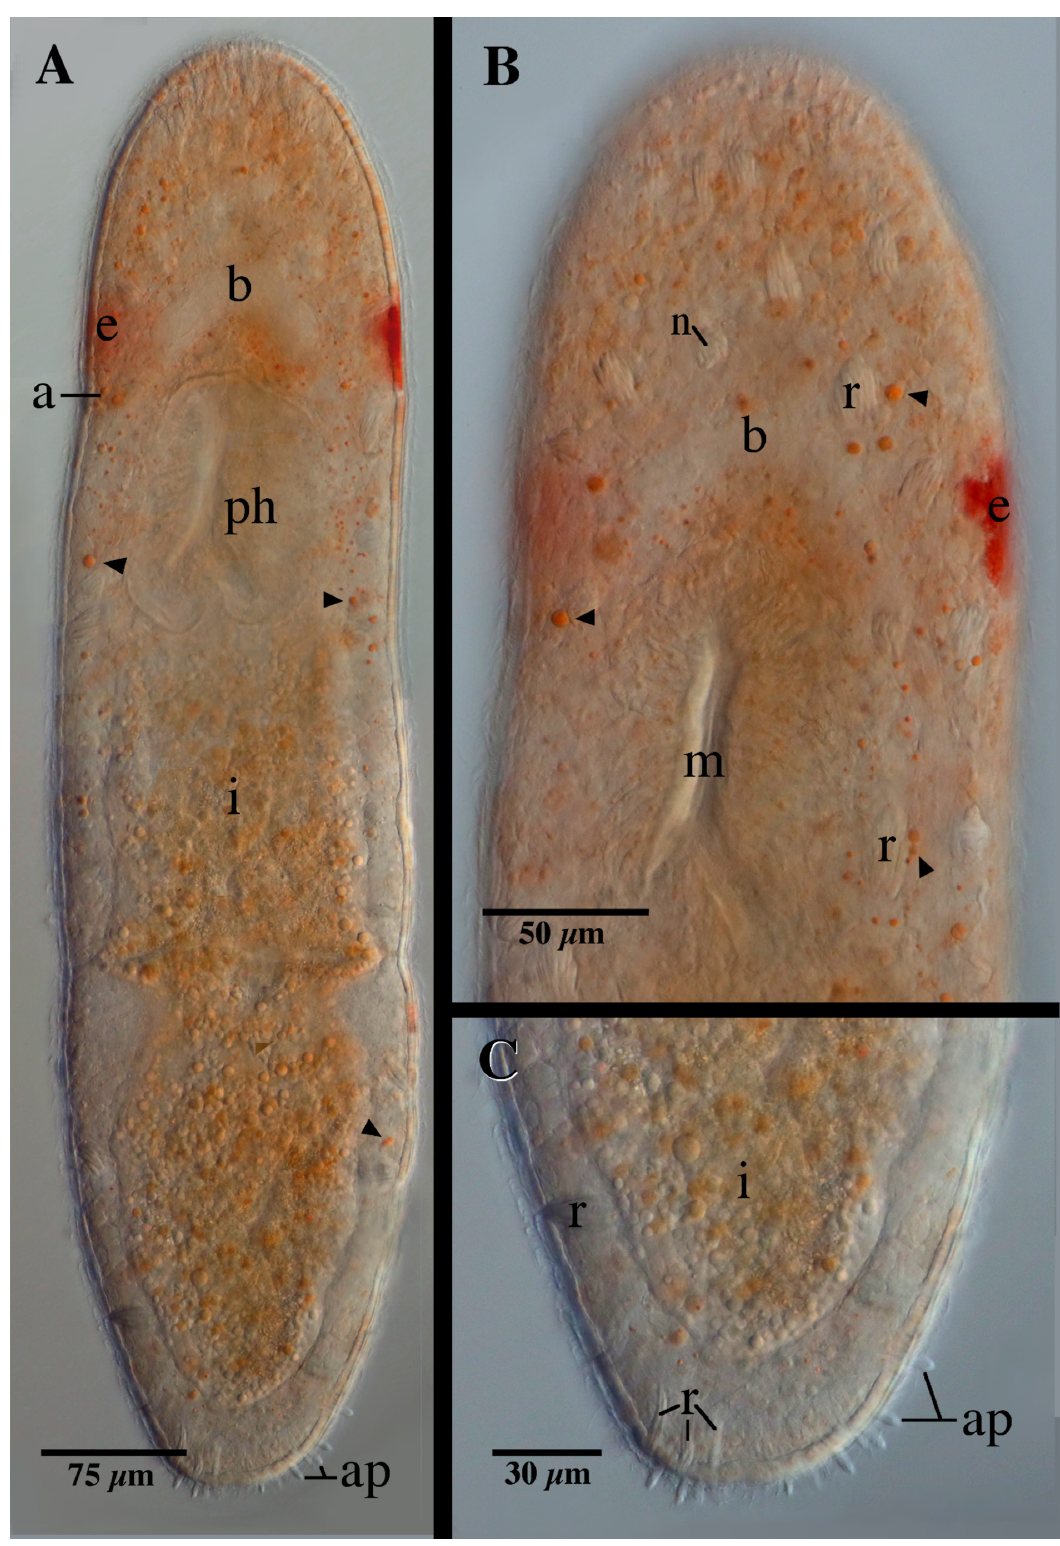
Fig. 1 . Microstomum laurae sp. nov. A . Composite image of whole body. B . Anterior end. C . Posterior end. Abbreviations: a = auricles (ciliary pits); ap = adhesive papillae; b = brain; e = eyespots; i = intestine; m = mouth; n = nematocyst; ph = pharynx; r = rhabdite. Arrowheads indicate orange